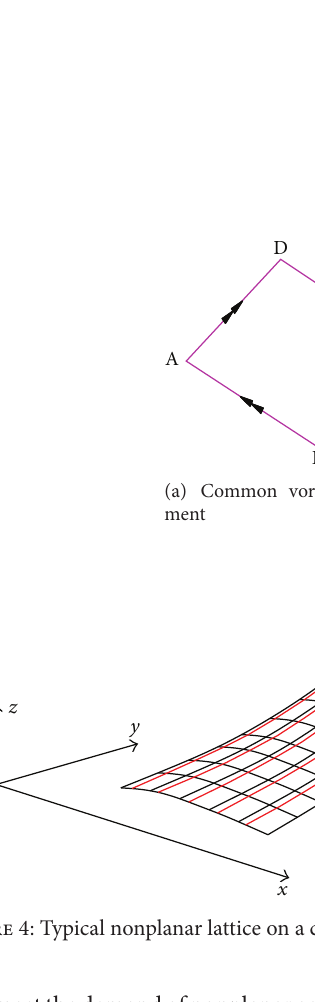
tions, mesh dividing should be determined on the deformed surface and updated along with the structure deflection, as shown in Figure 4. In addition to the spatial lattices, local coordinates should be established to reflect the exact nonplanar configuration of the wing. The nonplanar effect not only is reflected geometrically but also should be contained in the kernel function 𝐾